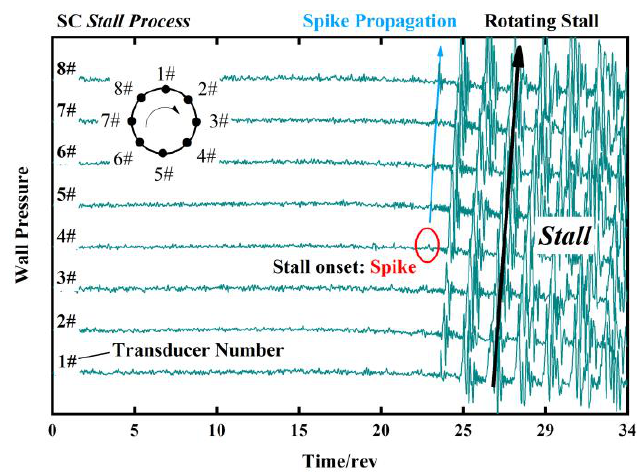
Figure 8. Eight wall pressure traces during the throttling of the compressor in SC .